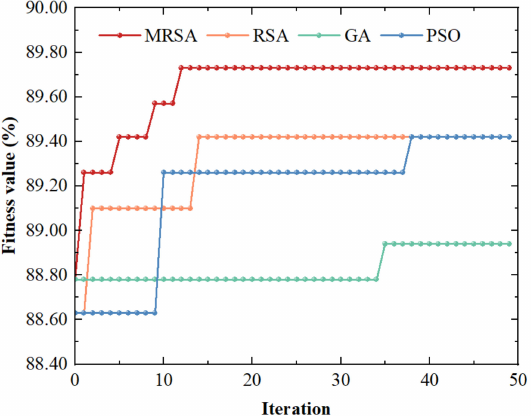
Figure 6. Optimization process of MRSA, RSA, GA and PSO algorithm.